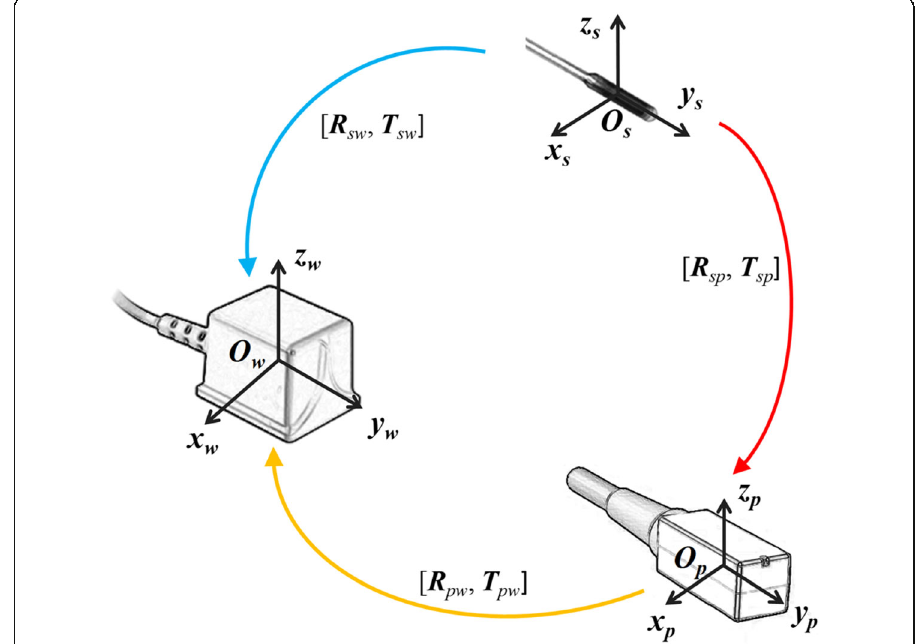
Fig. 4 Schematic diagram of transformations involved in the three coordinate